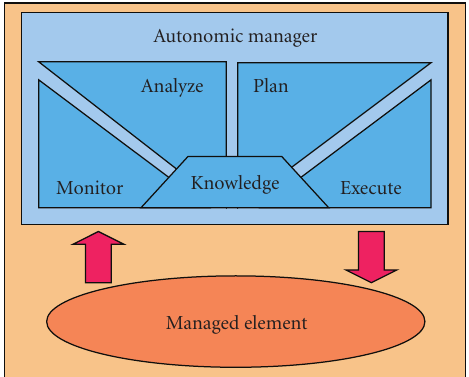
Figure 1: An autonomic element as presented in the vision of autonomic computing